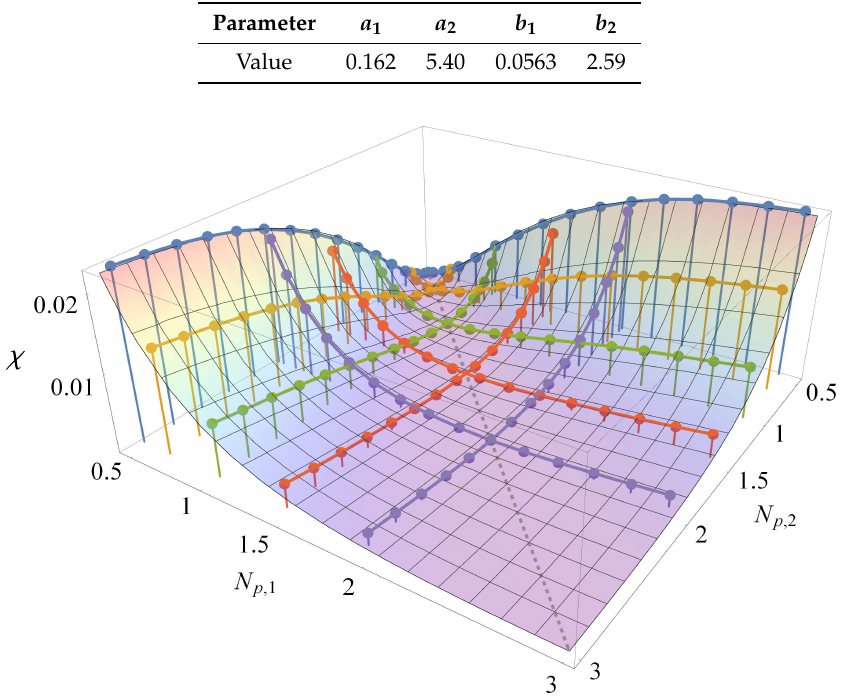
Table 1. Parameters for fitting χ ( N p ,1 , N p ,2 ) to simulation data.